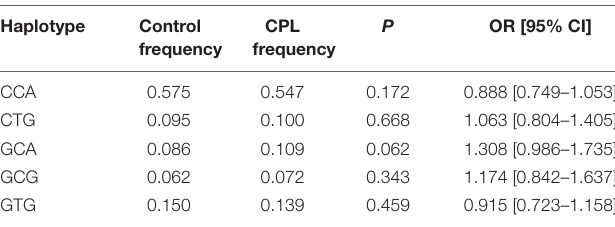
TABLE 6 | Association of ICAM-1 haplotypes with cervical precancerous lesion risk.